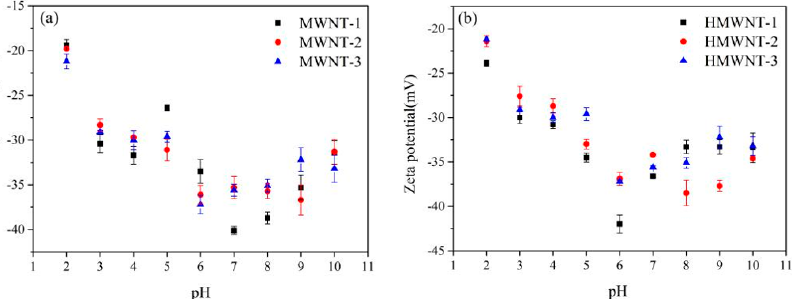
Figure 4. Zeta potential changes after HA adsorption of MWNTs ( a ) and HMWNTs ( b ) at different solution pH values .